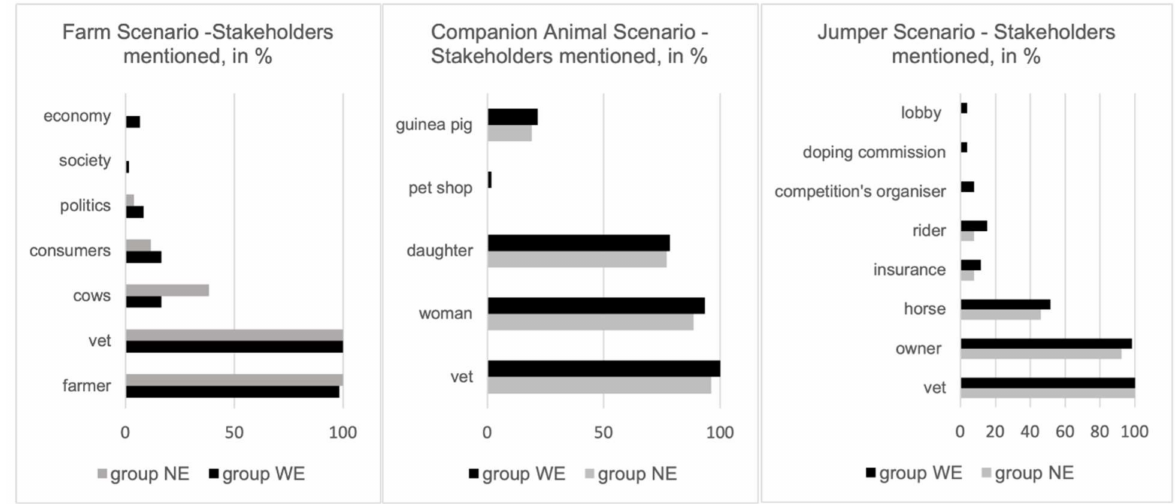
Figure 1. Stakeholders mentioned in the three scenarios, both groups. Answers in %.